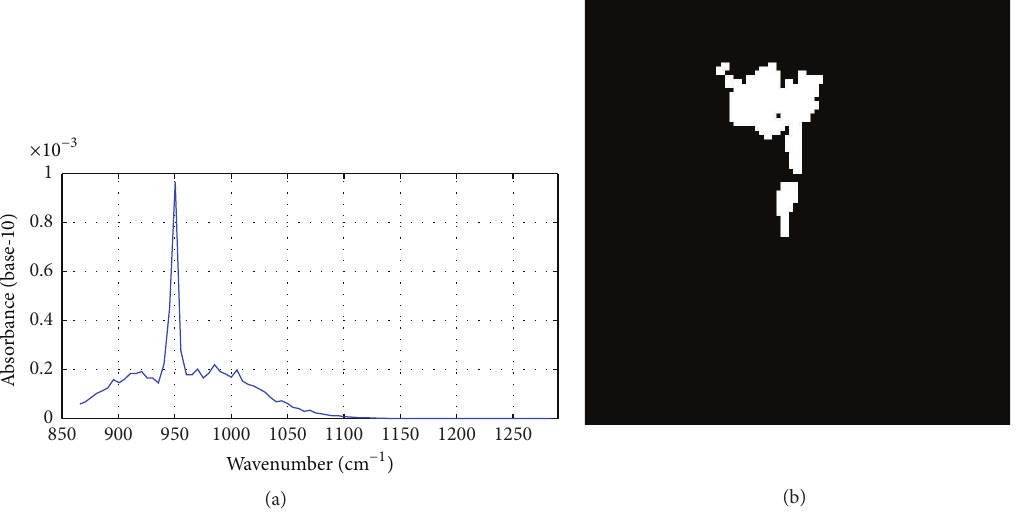
Figure 13: Ethylene release detection. (a) Absorptive coefficient spectrum of ethylene (from PNNL). (b) Plume detection mask for Telops parking